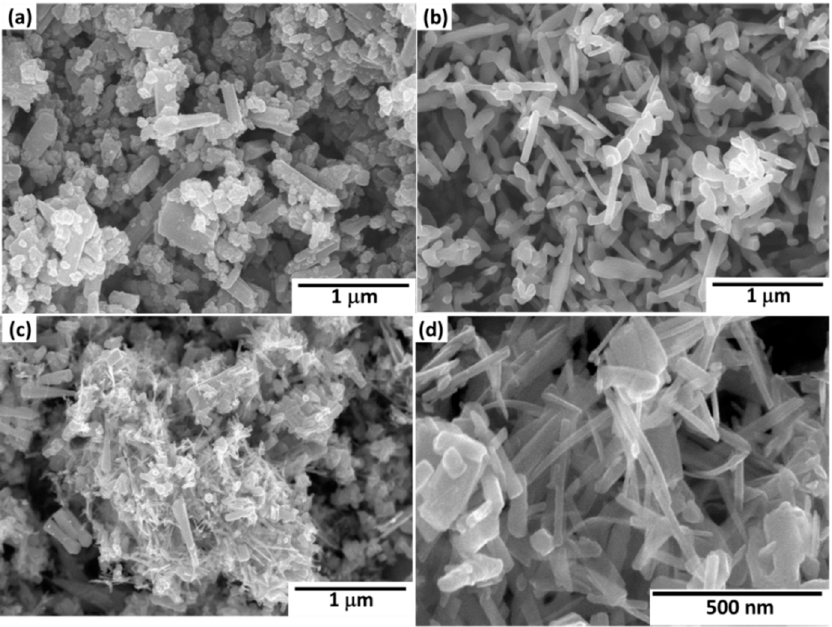
Figure 10. SEM micrographs of the Al/TiC nanofibers after mixing: ( a ) 1 wt % TiC; ( b ) 2 wt % TiC; ( c ) 3 wt % TiC; ( d ) 5 wt % TiC with high magnifications. ( c ) 3 wt % TiC; ( d ) 5 wt % TiC with high